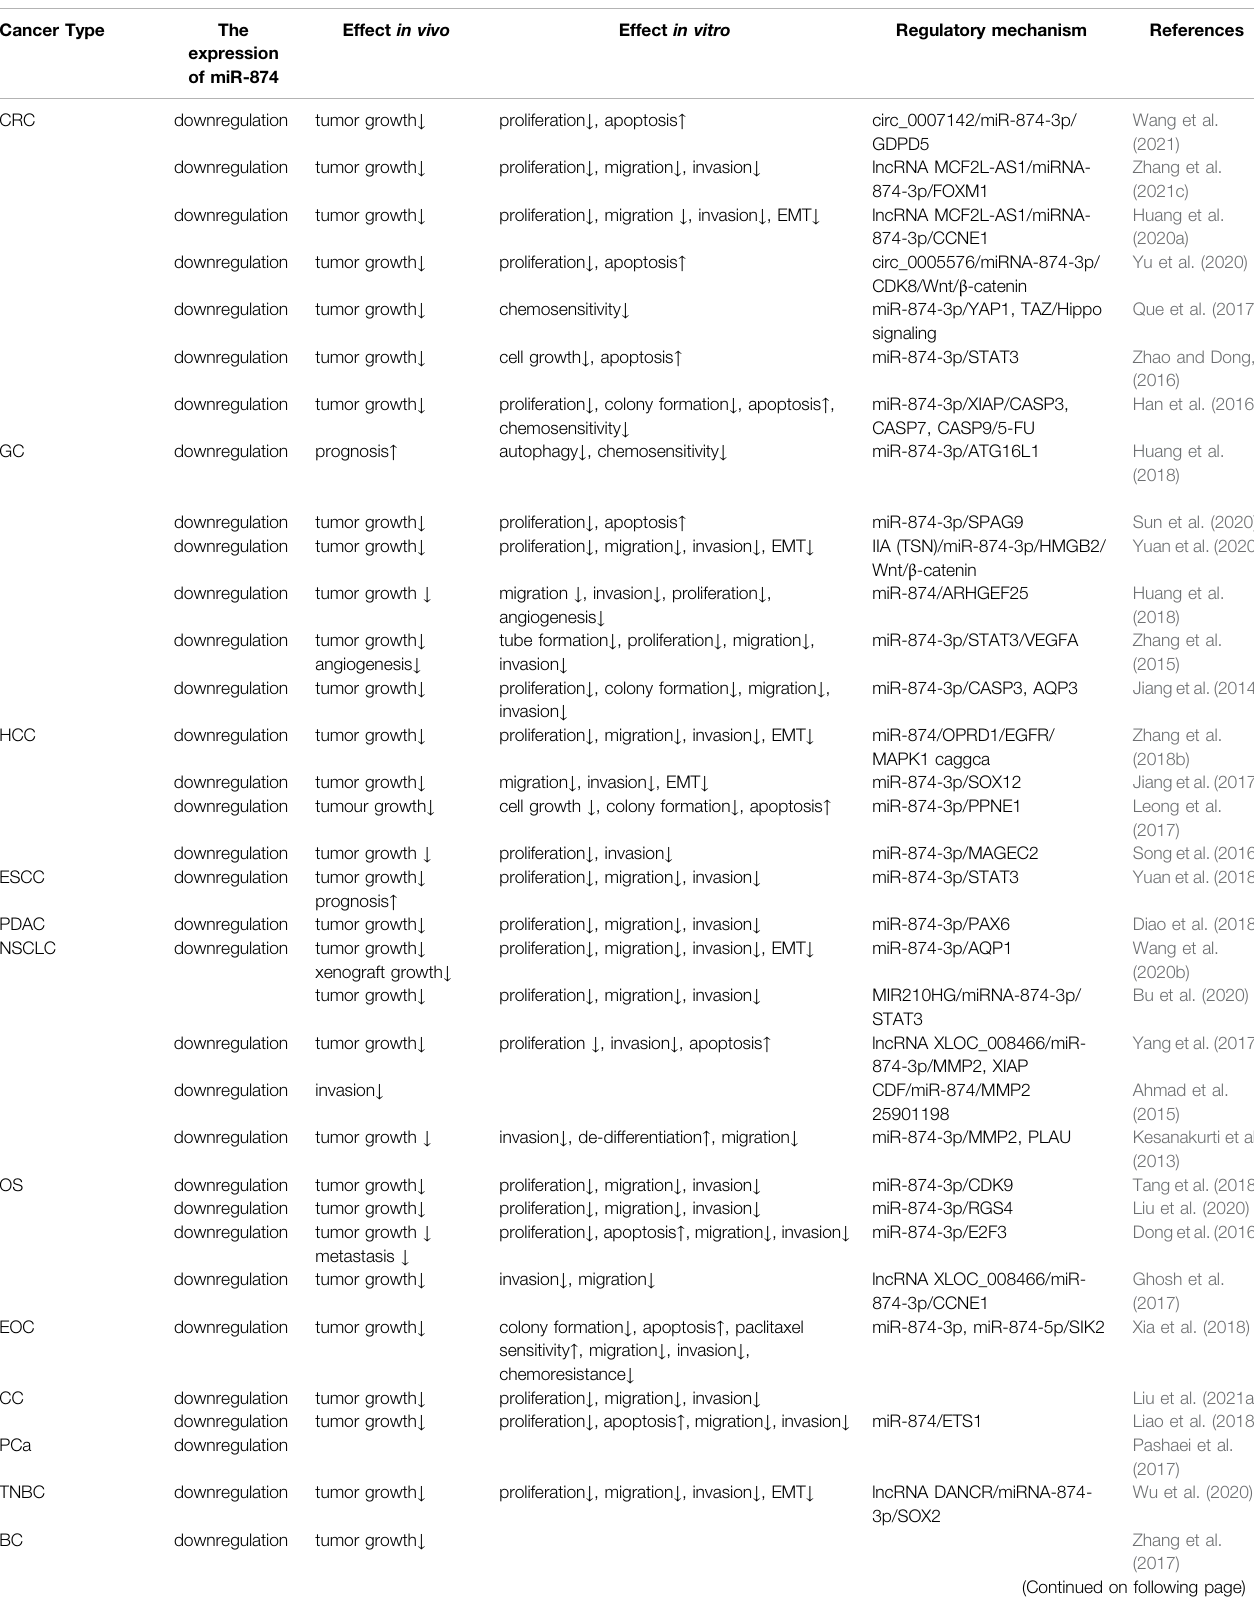
TABLE 1 | The role of miR-874 in various